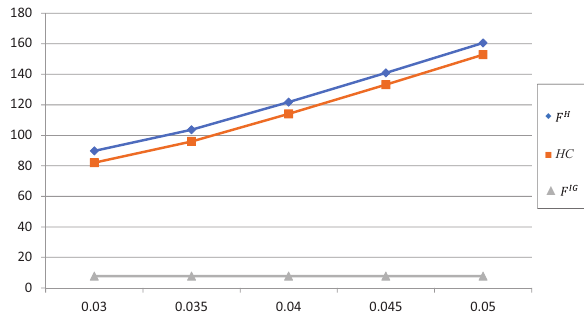
Figure 2. Utility rental benefit rate and housing value